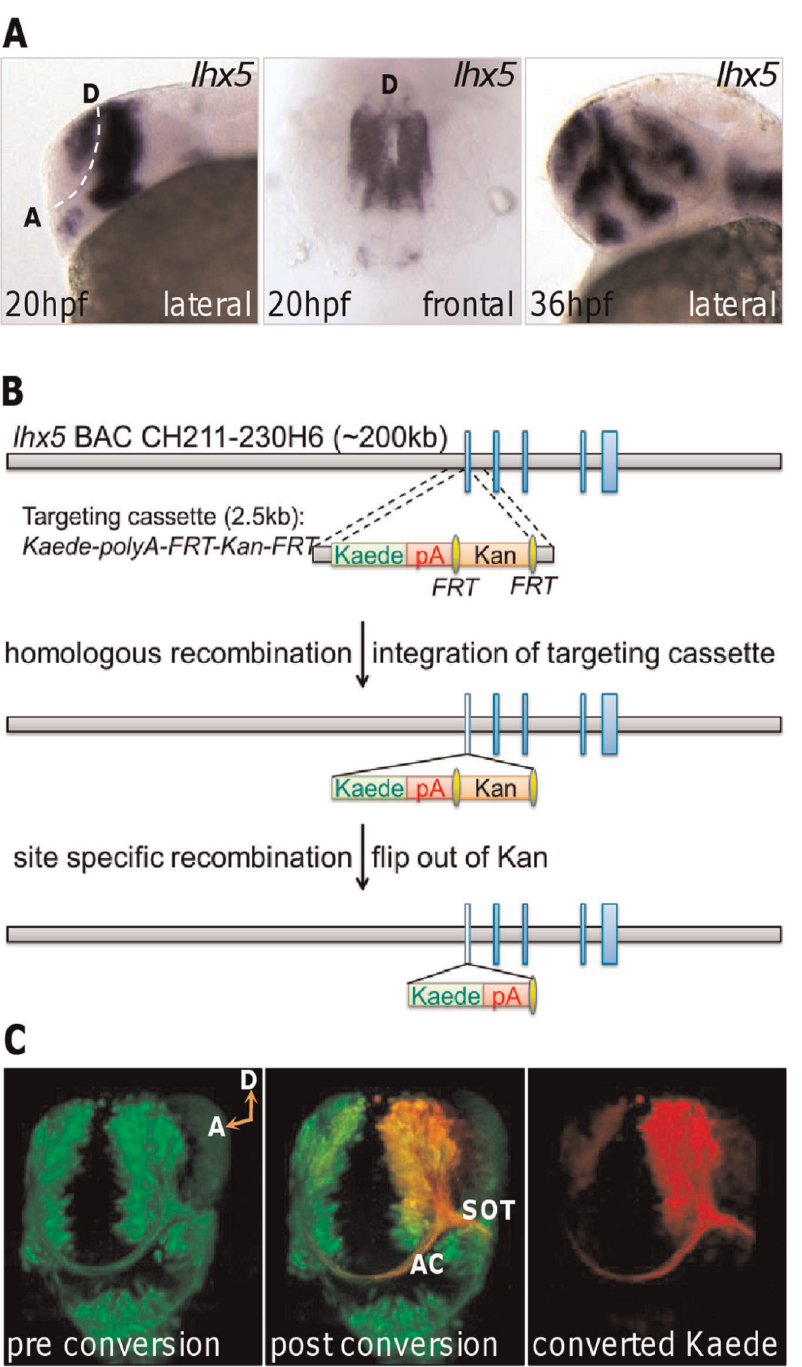
Figure 1. ADt neurons project axons ventrally. In this and subsequent figures, the probes used for whole-mount in situ hybridization are listed in the upper right corner of each panel. Developmental stages are indicated in the lower left corners. Lateral, animals mounted in lateral view, rostral to the left; Frontal, animals mounted in frontal view, dorsal to the top. ( A ) lhx5 is expressed in the anterior dorsal region of the telencephalon. Dashed line marks the telencephalon-diencephalon border. D: dorsal; A: anterior ventral. Scale bar: 100 m m for lateral view; 60 m m for frontal view. ( B ) BAC modification via recombination methods. Vertical blue bars represent exons of the lhx5 gene. The Kaede expression cassette replaced the first exon of lhx5 gene. pA: polyadenylation signal sequence; Kan: kanamycin resistant marker; FRT , flippase recognition target. ( C ) Photo-conversion of Kaede in Tg(lhx5BAC:Kaede) transgenic embryos demonstrates ADt neurons project axons ventrally into the AC and SOT. A live Tg(lhx5BAC:Kaede) transgenic animal was mounted in tilted frontal view to reveal the AC and SOT simultaneously. The region of the left telencephalon was selected for photoconversion. D: dorsal; A: anterior ventral; AC: anterior commissure; SOT: supraoptic tract. Scale bar: 60 m m.